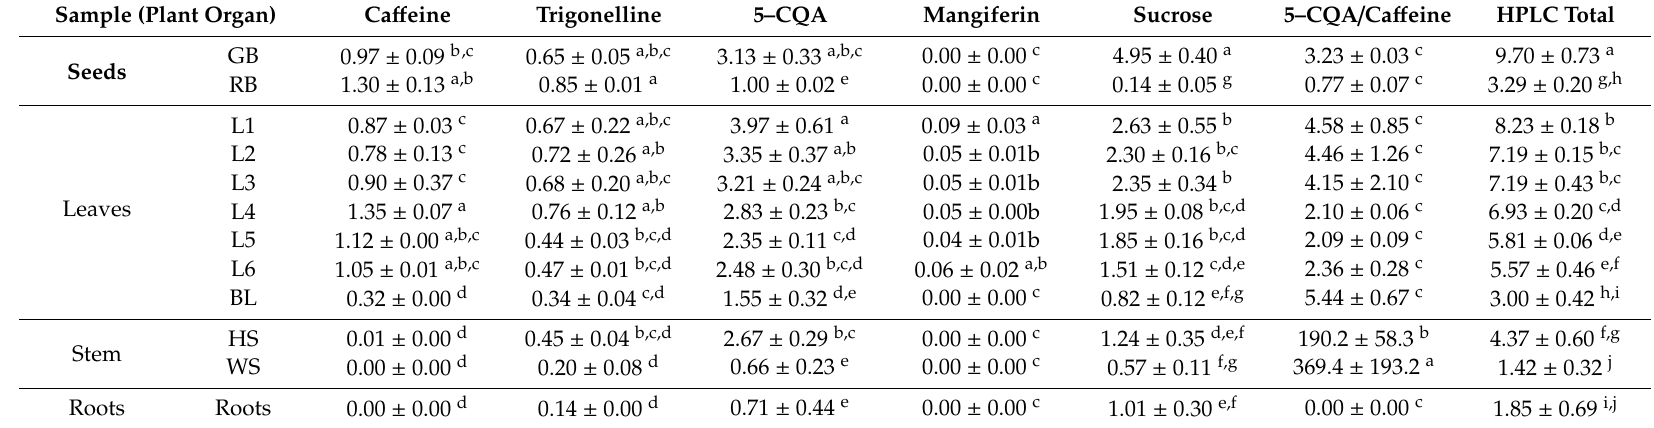
Table 2. HPLC phytochemical profile of co ff ee plant organs expressed as unit weight per freeze-dried sample (mg g − 1 DW). Sample (Plant